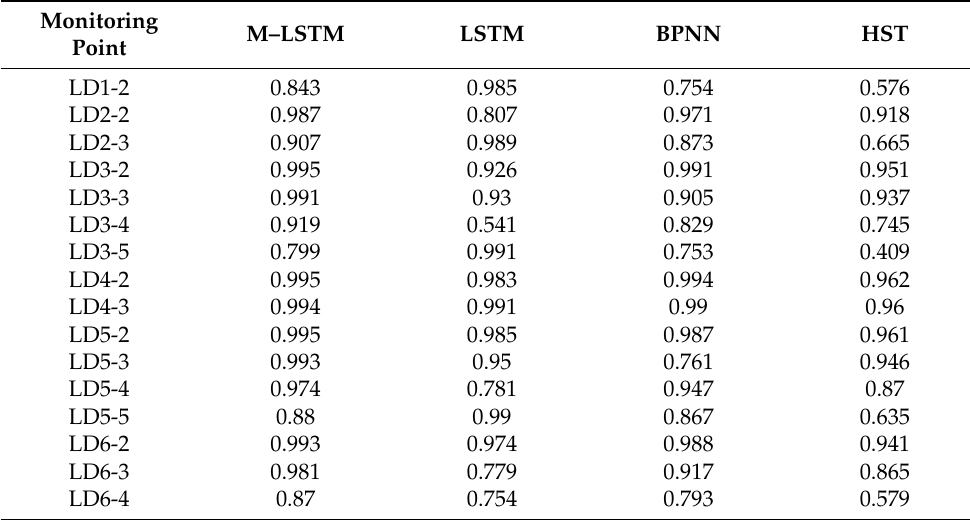
Table 2. R 2 of M–LSTM, LSTM, BPNN, and HST models.